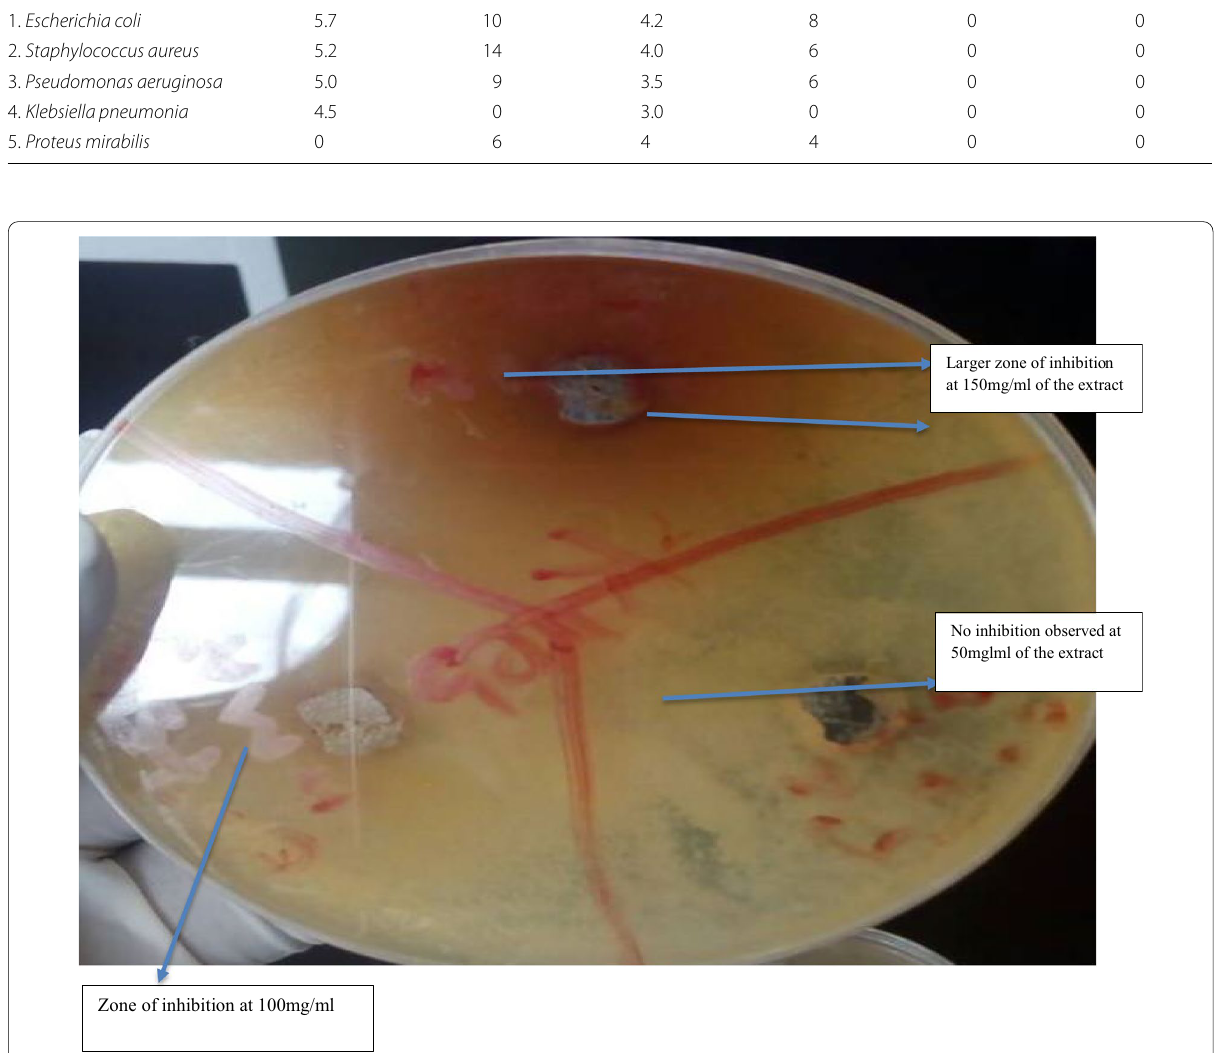
Fig. 3 Zone of inhibition of onion ethanol extract on Klebsiella pneumonia at 150